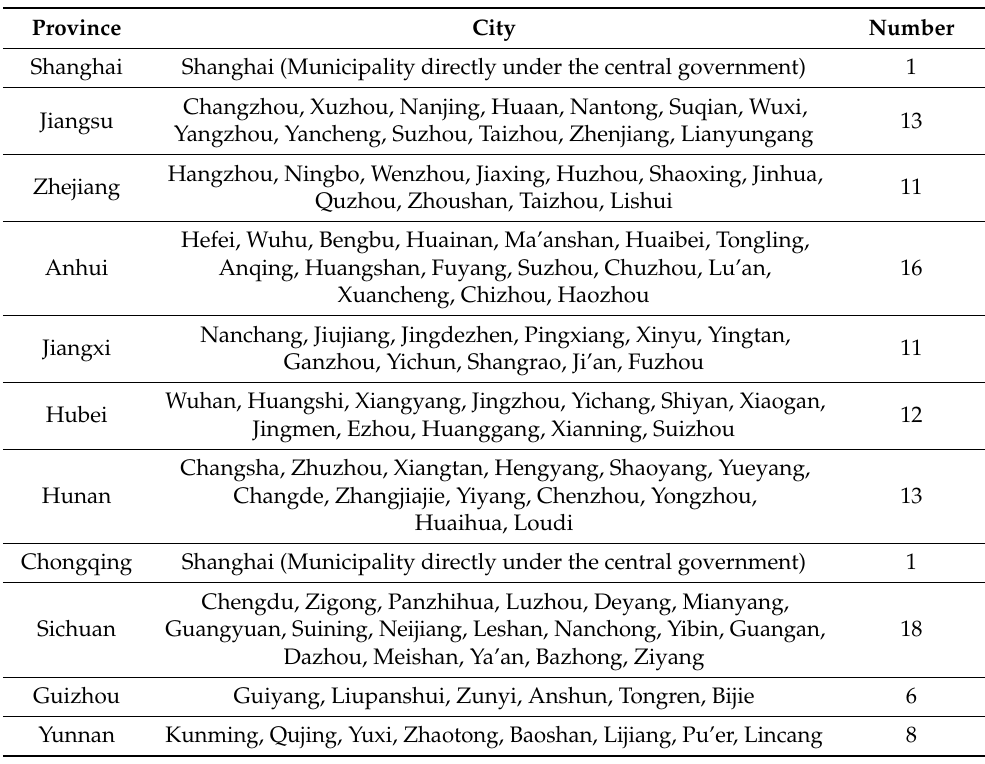
Figure 1. Location of the Yangtze River Economic Belt administrative division. Table 1. Distribution statistics of 110 cities in the Yangtze River Economic Belt.